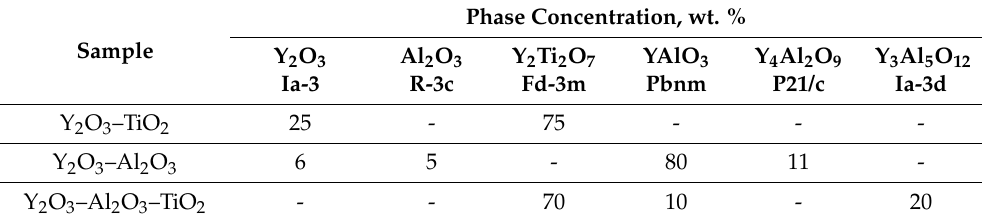
Figure 12. The X-ray patterns of the Y 2 O 3 –TiO 2 , Y 2 O 3 –Al 2 O 3 , and Y 2 O 3 –Al 2 O 3 –TiO 2 powder mixtures sintered at 1100 °C. Table 6. The phase composition of the Y 2 O 3 –TiO 2 , Y 2 O 3 –Al 2 O 3 , and Y 2 O 3 –Al 2 O 3 –TiO 2 powder mixtures sintered at 1100 °C.